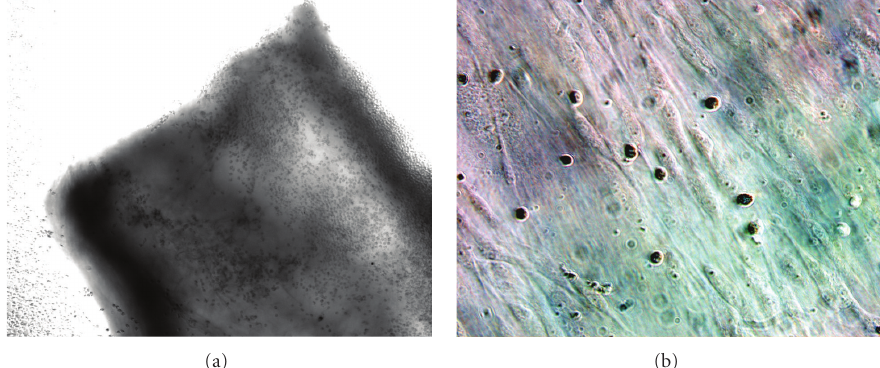
Figure 2: (a) Human eosinophils immediately ( < 10min) adhere to freshly isolated human airway in vitro. Human eosinophils adhere to adventitial surface of human airway and epithelial surface (not seen) (bronchial diameter = 1.5mm, phase contrast 100x). (b) Eosinophils immediately ( < 10min) adhere to cultured human airway myocytes. Wright’s stain of eosinophils adhering to passage 1 serum-deprived elongated airway myocytes (phase contrast 600x).